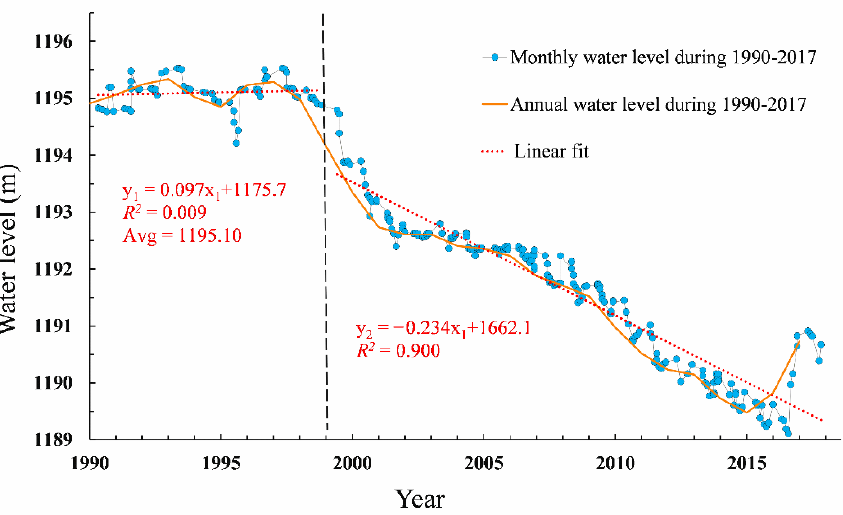
Figure 6. Changes in and trend of the lake area of HN during 1990–2017.